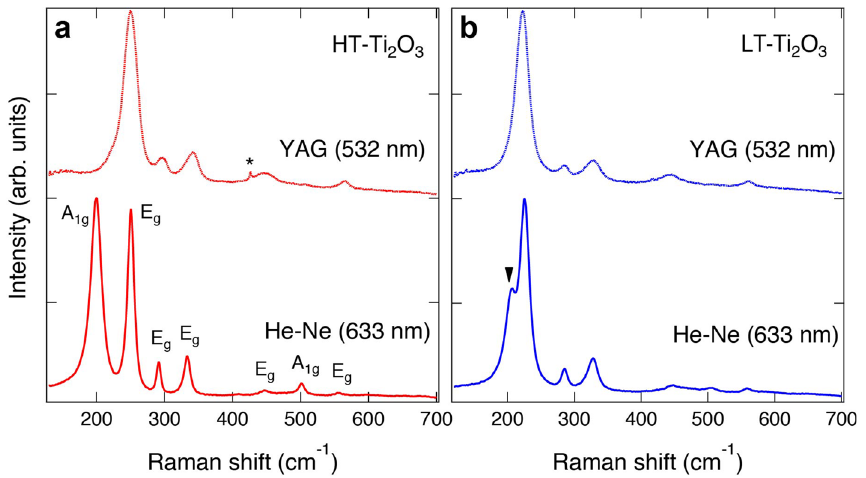
Figure 1. Investigation of corundum-type crystal structure in the Ti 2 O 3 films. Raman spectra of ( a ) HT- and ( b ) LT-Ti 2 O 3 films measured at RT. The spectra were collected using YAG (dotted lines) and He–Ne (solid lines) lasers. Vibrational modes ( A 1g or E g ) are indicated in the spectrum of the HT-Ti 2 O 3 film recorded using He–Ne laser. The triangle in ( b ) indicates the peak related to the low-frequency A 1g mode. The asterisk indicates the peak from the α -Al 2 O 3